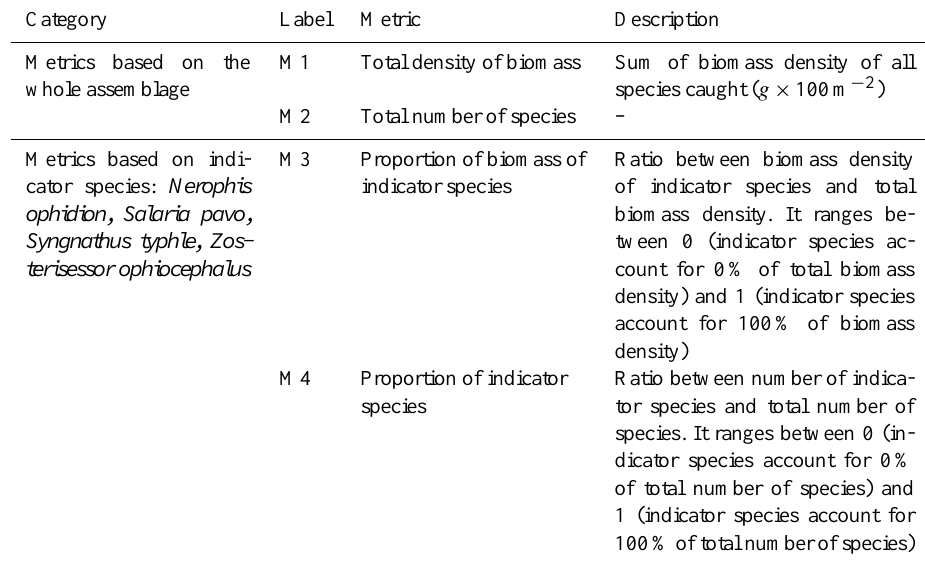
Table 2. Description of candidate metrics for the evaluation of the success of seagrass restoration in the Venice